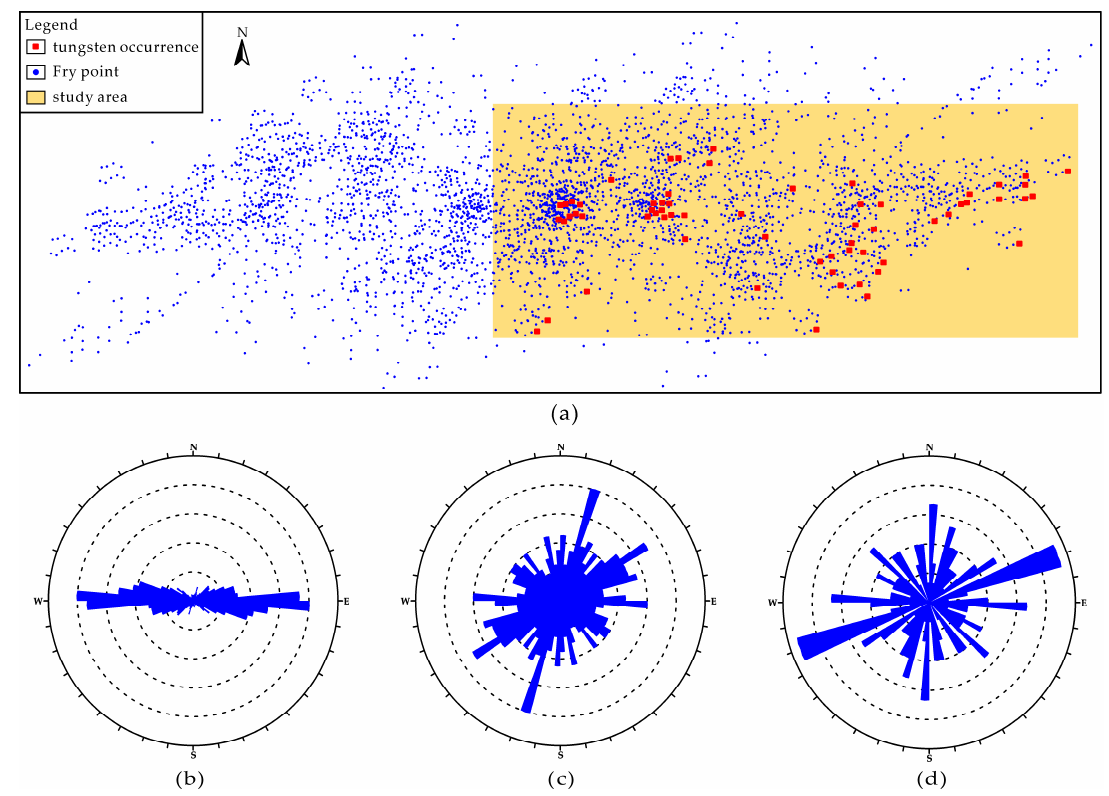
Figure 5. ( a ) Fry plot showing spatial distribution of Fry points derived from 63 copper occurrences; and rose diagram for ( b ) all Fry points; ( c ) Fry points within 4.5 km; ( d ) Fry points within 1.5 km.